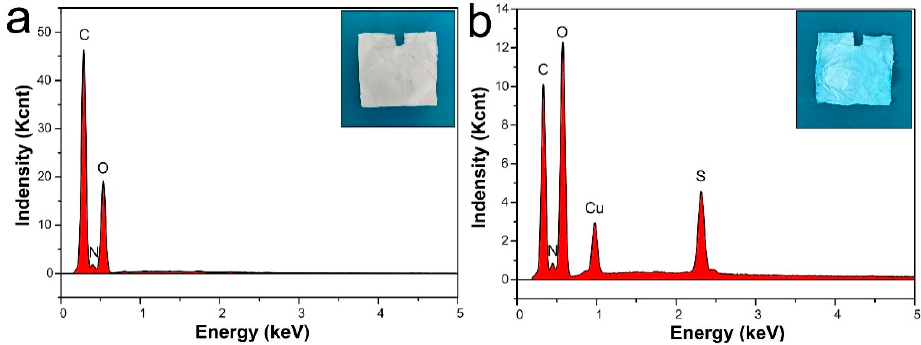
Figure 10. EDS spectra for CS-L3 membrane before ( a ) and after ( b ) Cu(II) adsorption.